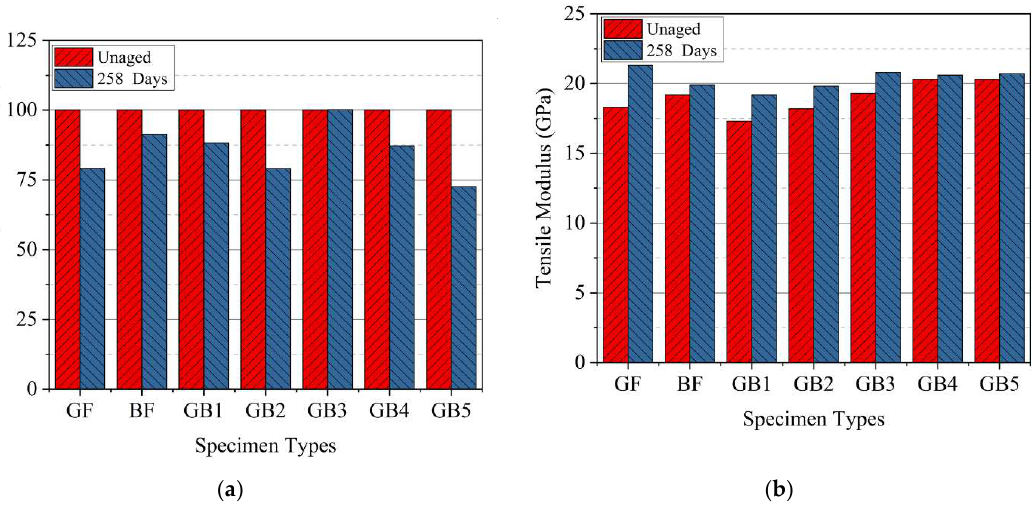
Figure 7. Tensile ( a ) strength retention ( b ) modulus of specimens in dry and seawater aged condition.